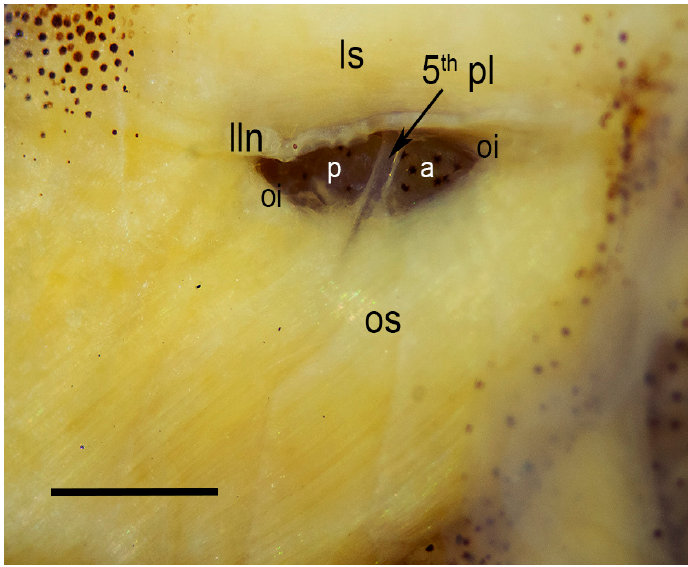
FIGURE 4 | Pseudotympanum in Characidium onca (MZUSP 125801, paratype). Abbreviations: 5 th pl, pleural rib of fifth vertebra; a, anterior window of pseudotympanum; lln, lateral line nerve; ls, lateralis superficialis ; oi, obliquus inferioris ; os, obliquus superioris ; p, posterior window of pseudotympanum. Scale bar = 1